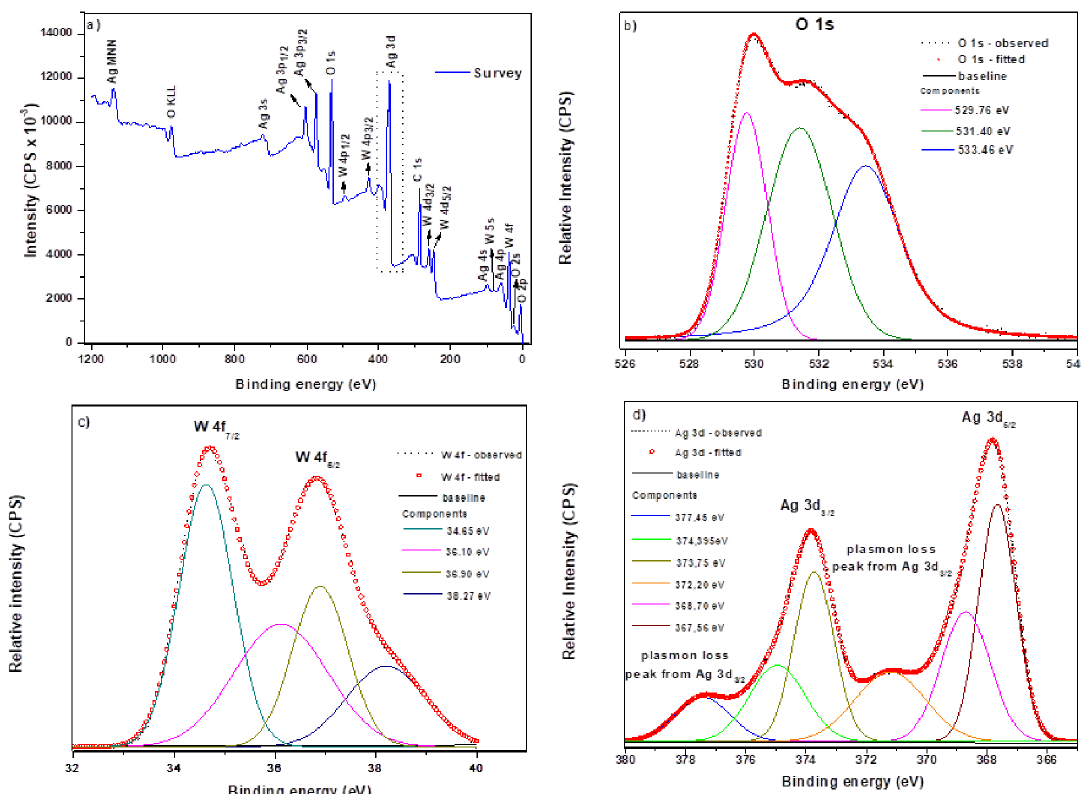
WO processed by the MAH method. (a) High-resolution XPS spectra of the α - Ag 2 4